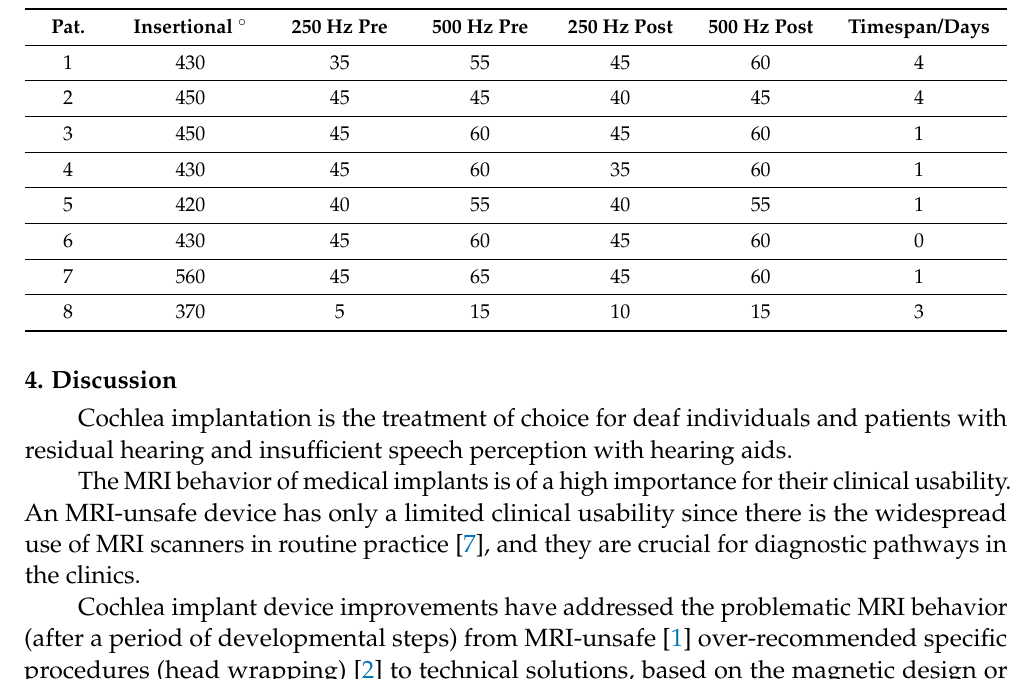
Table 1. Legend Table 1: individual BC PTA data pre and post MRI scanning, insertional angle in ◦ and the timespan between MRI scan and post-scanning BC PTA in days.